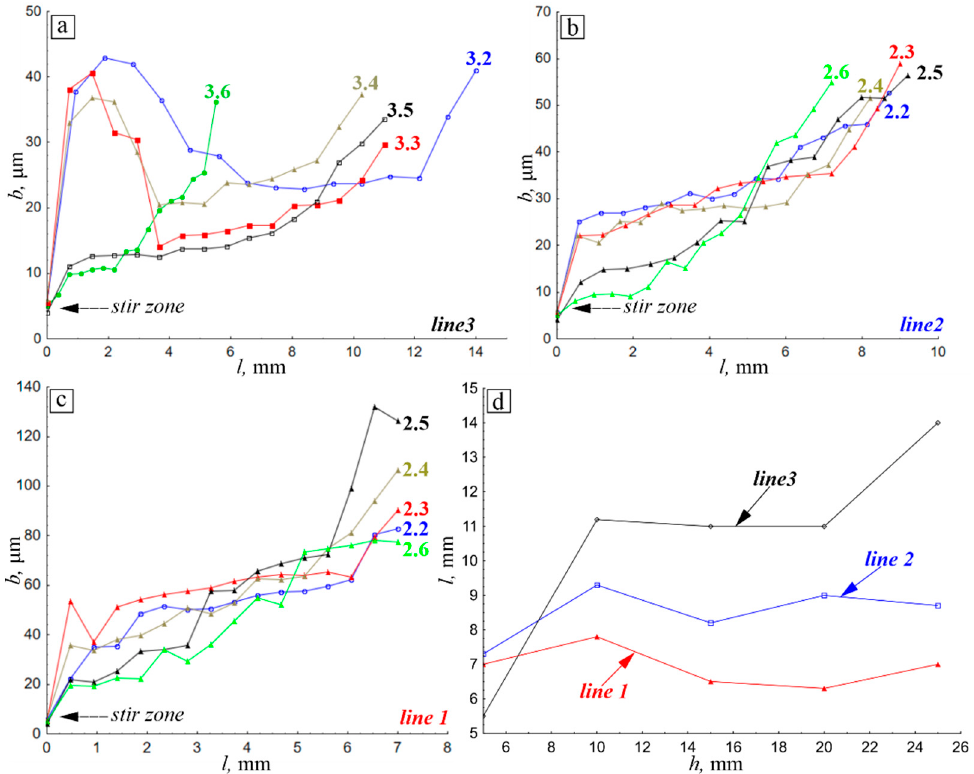
Figure 8. The TMAZ grain size distributions as measured along lines 3 ( a ), 2 ( b ), and 1 ( c ) (in Figures 5 and 6 ( a , c )) and the dependence of the TMAZ size on the height of the 30 mm thick sample ( d ). The diagram labels are in accordance with those of the diagram in Figure 3.